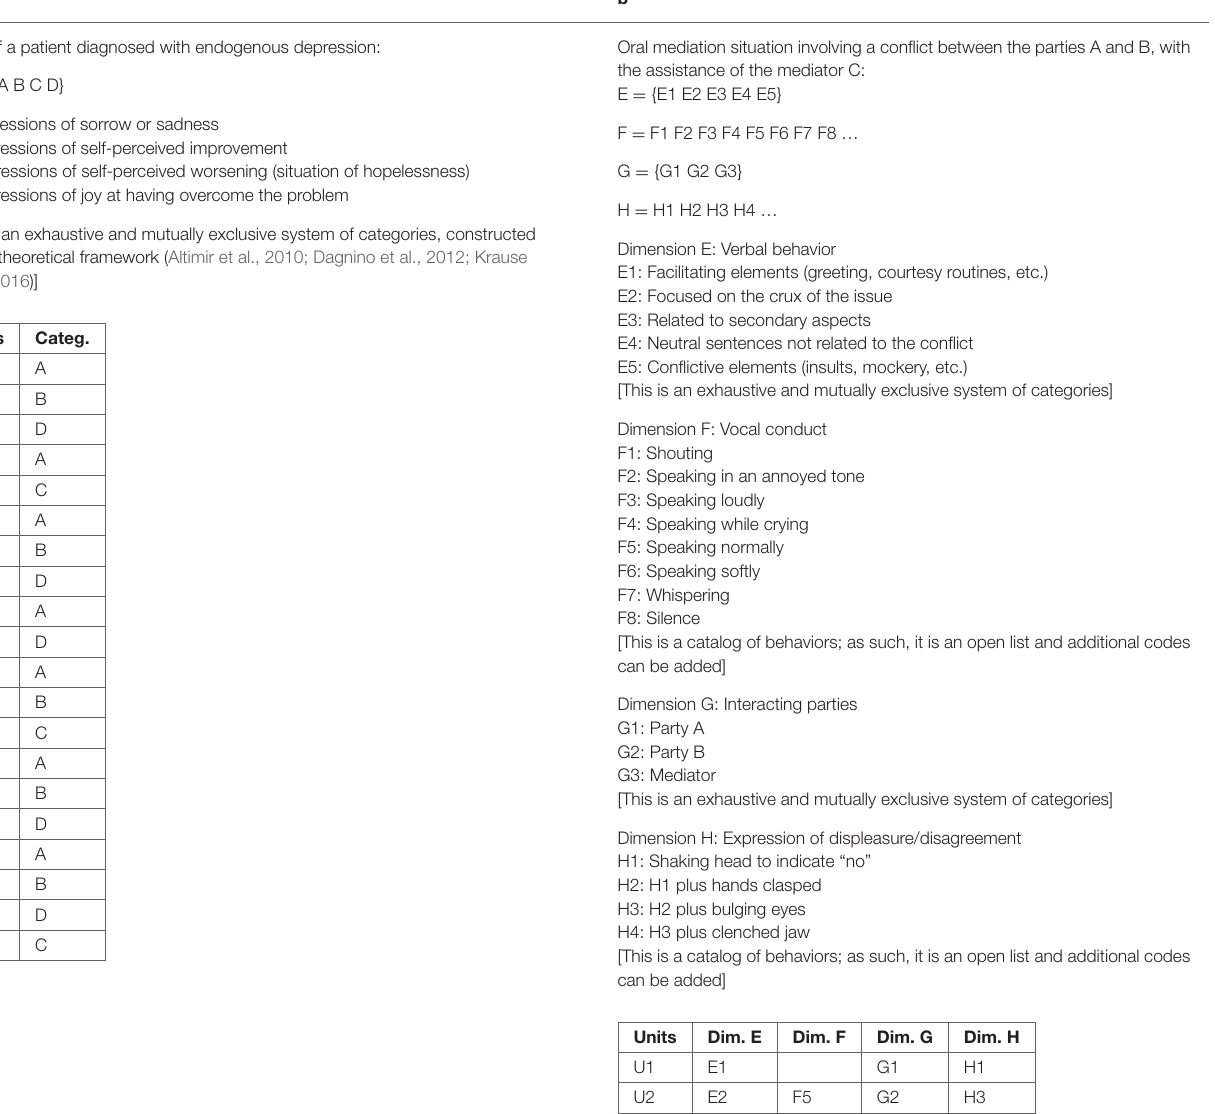
TABLE 3 | (a,b) Hypothetical examples of a code matrix derived from a text. a b Diary of a patient diagnosed with endogenous depression: SC = {A B C